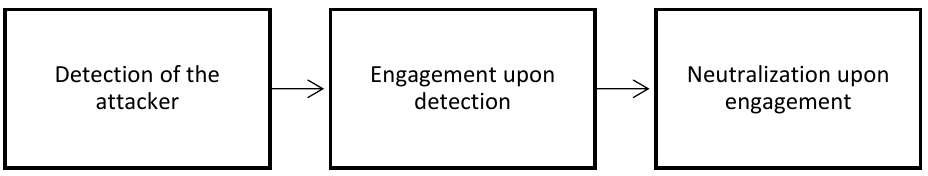
Figure 3. The assumed defensive system process steps in the security zone.